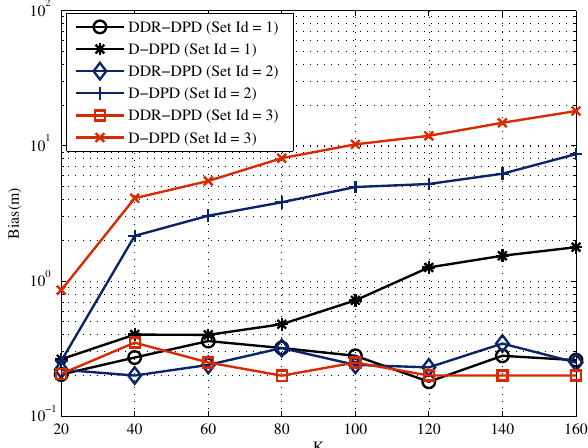
Figure 7. Bias vs. pulse number in each coherent pulse